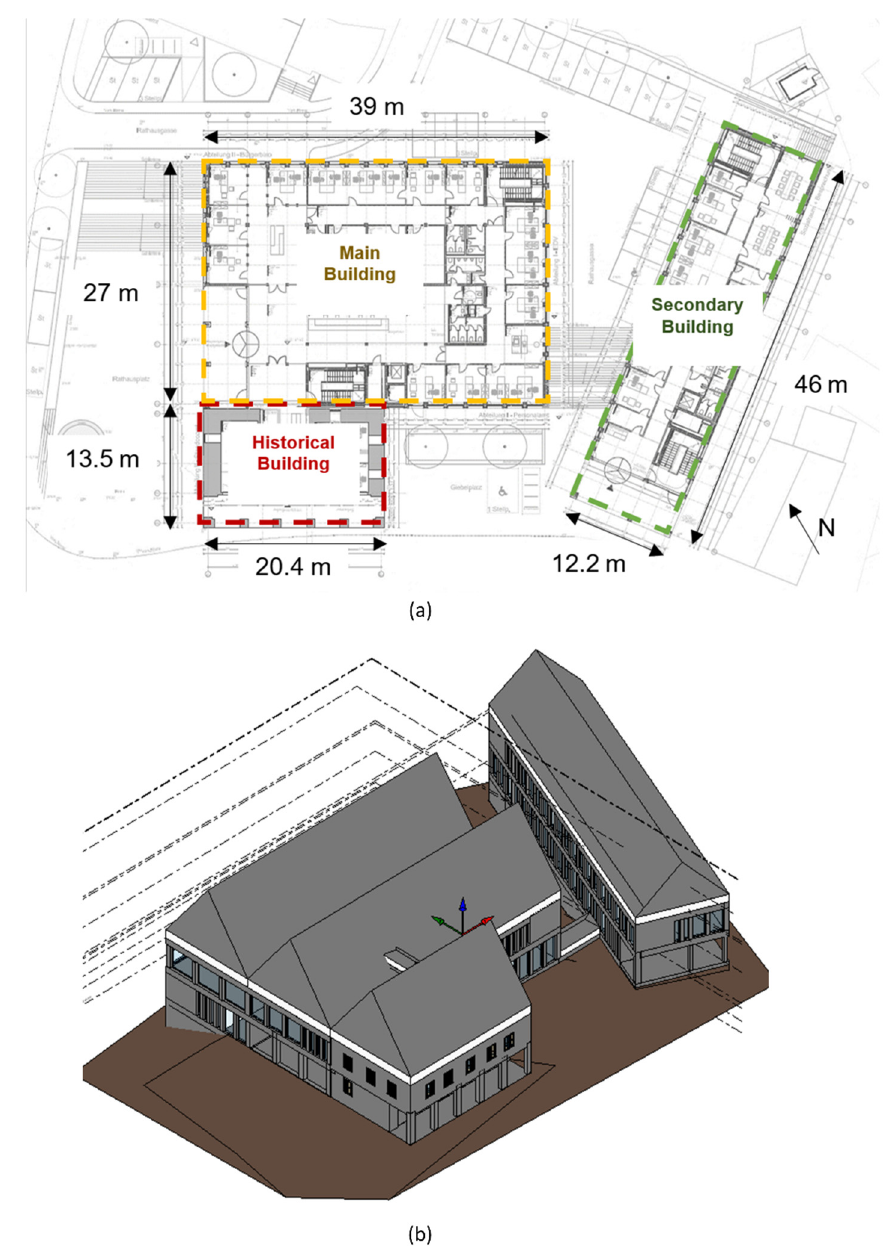
Figure 2. ( a ) Floor plans of the case study building after [42], ( b ) Buildings model. The first floor of the main building has a 209 m 2 parking lot. Technical areas and ancillary spaces are located partly on the first floor and under the roof. The buildings were modeled using the BIM software Autodesk Revit [43], based on the planning documents elements are described in Table